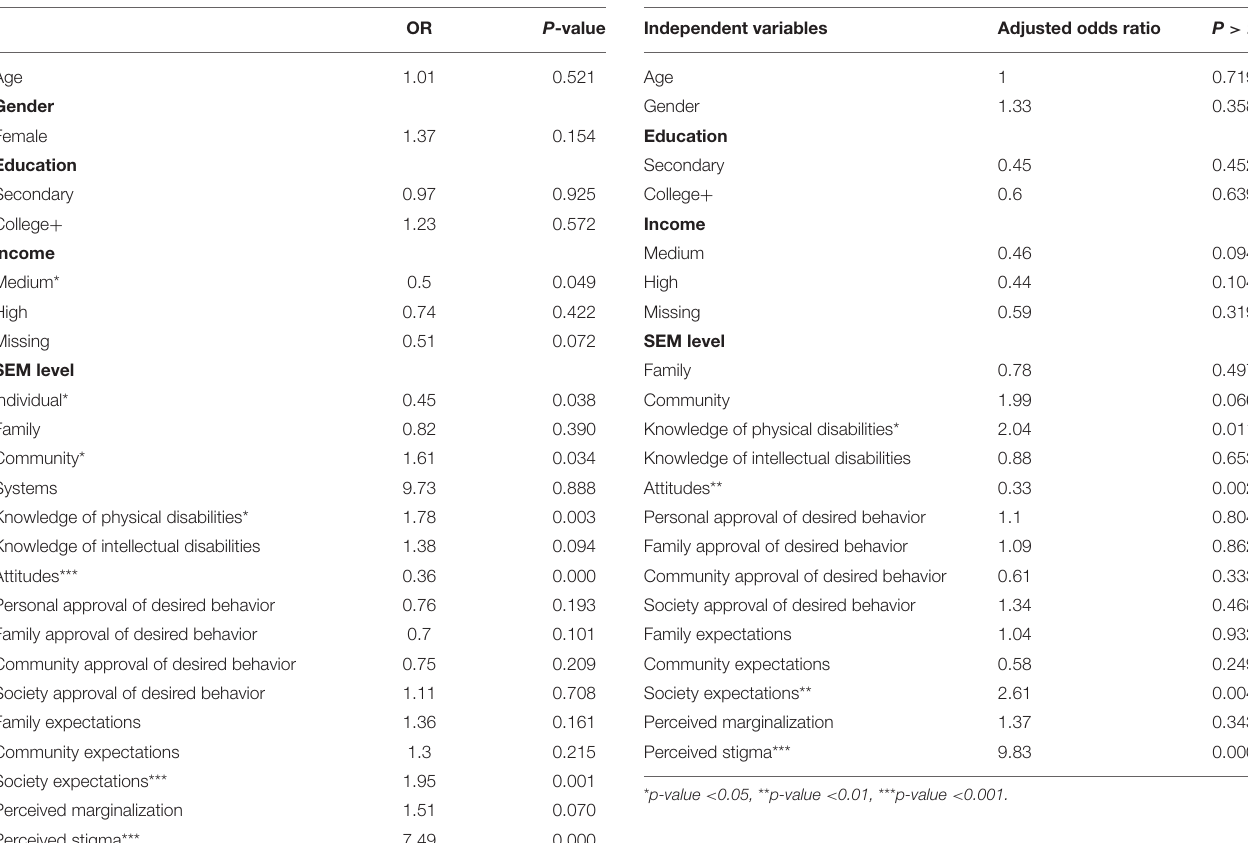
TABLE 5 | Multivariate logistic regression results with stigma as the dependent